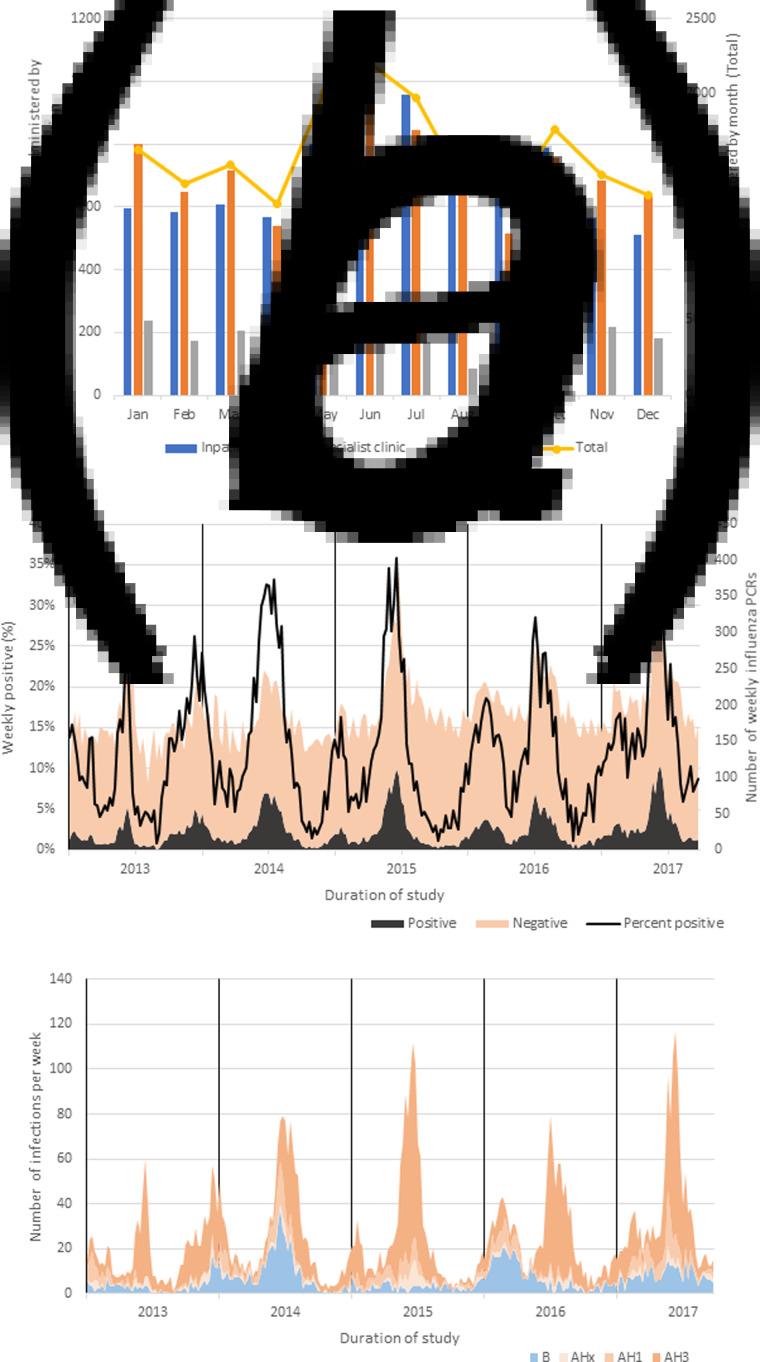
(A) Number of influenza vaccines administered by month and vaccination location (all years combined); (B) weekly number of unique influenza PCRs conducted at Tan Tock Seng Hospital over the course of the study with a positive or negative result; (C) weekly influenza subtype/type results reported from positive influenza PCRs. AHx, Influenza A, subtype undetermined.